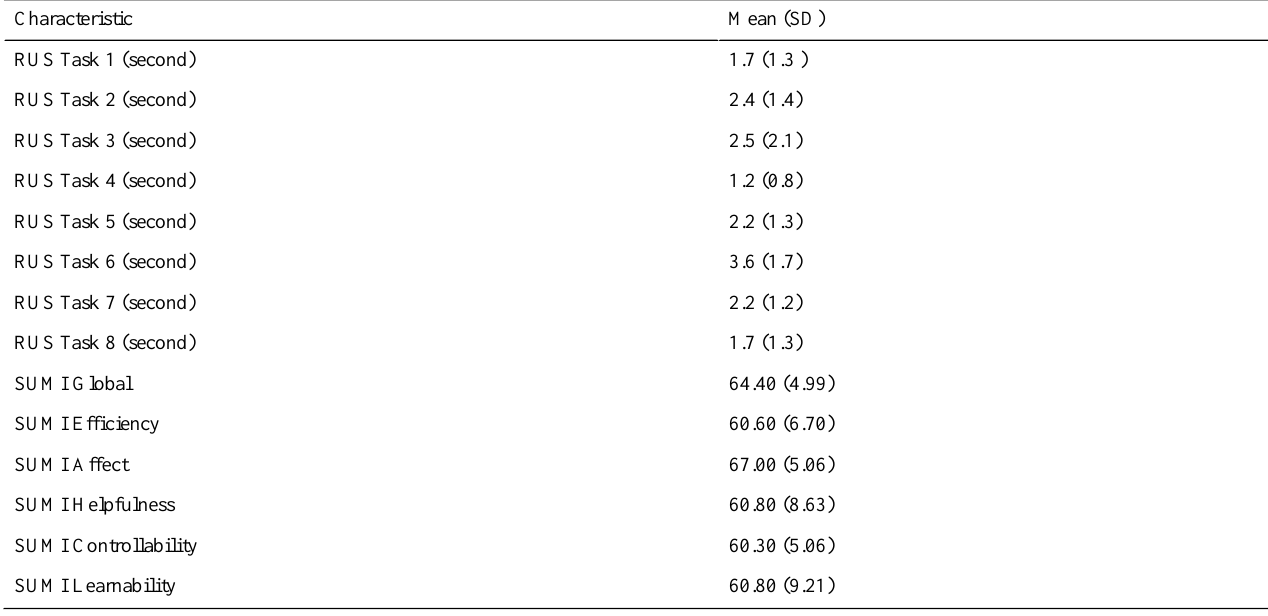
Table 2. Relative user efficiency and SUMI